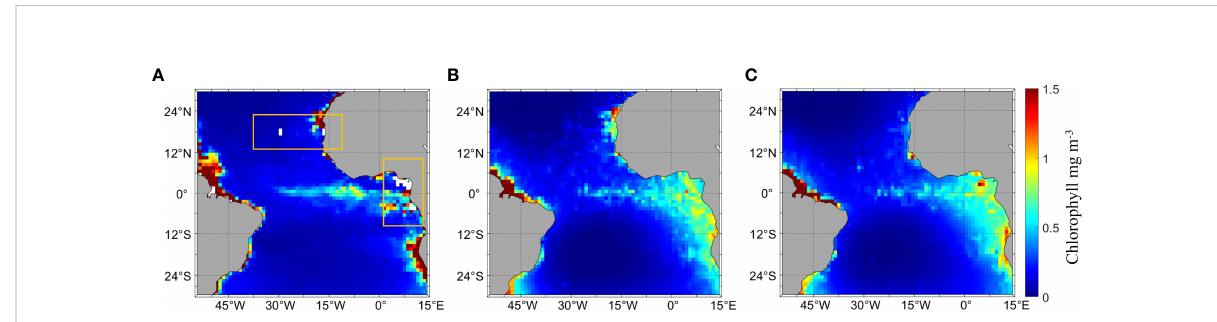
FIGURE 3 Comparison of the distribution of Chl_a between MODIS and CALIPSO and the circadian distribution of Chl_a in CALIPSO, (A) is the Chl_a of MODIS, the area in the yellow box is the missing data of the MODIS data, (B, C) is the Chl_a inversion by CALIPSO; (B) is the daytime distribution, (C) is the nighttime